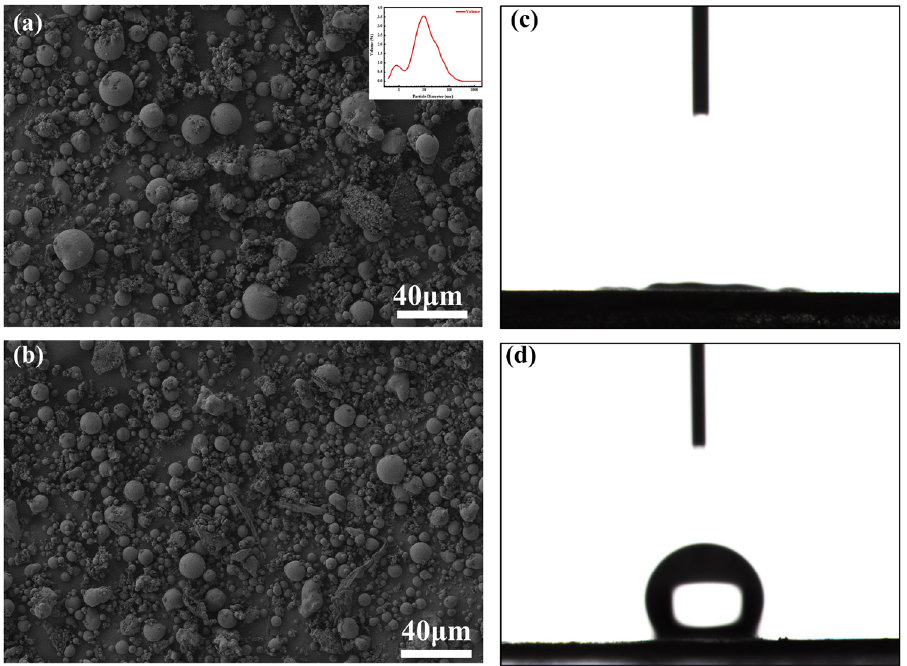
Figure 3: SEM images of ( a ) CFA particles and ( b ) modi fi ed CFA particles ( inset in ( a ) is the particle - size distribution ) . Contact angle measurements for ( c ) CFA and ( d ) modi fi ed